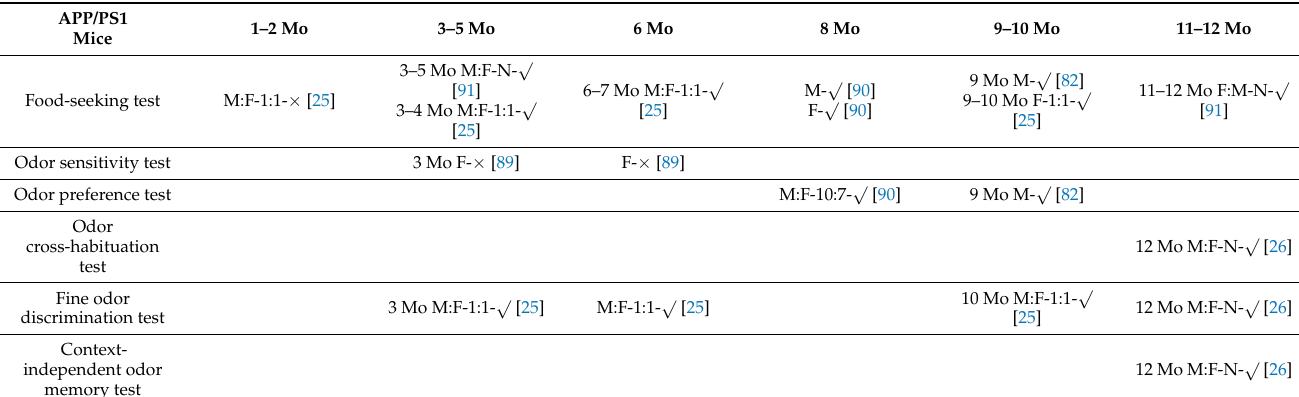
Table 2. Summary of data on the behavioral performance of the APP/PS1 mice; “3–5 Mo-M:F-1:1-X” represents “age-sex-sex ratio-whether there is a difference”. Mo: month, M: male, F: female, N: √ unclear, × : no significant difference, : significant